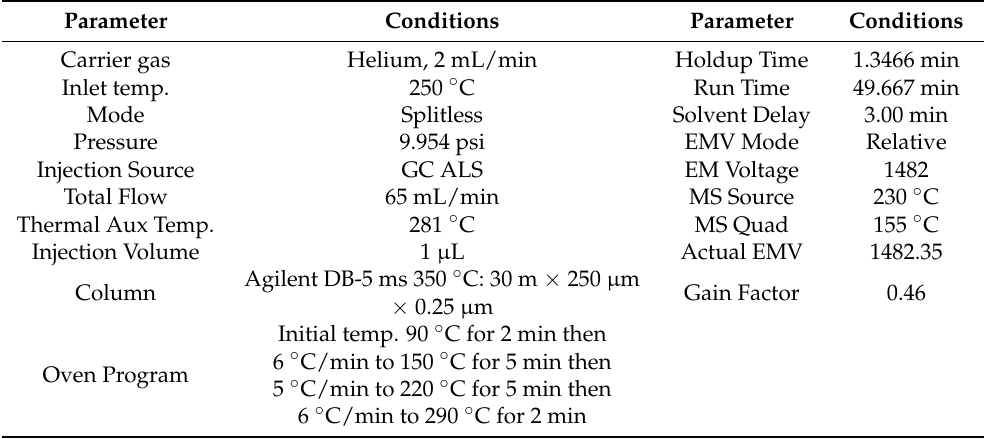
Table 2. Gas chromatography mass spectrometry total ion chromatogram (GCMS-TIC) parameters for pesticide analysis